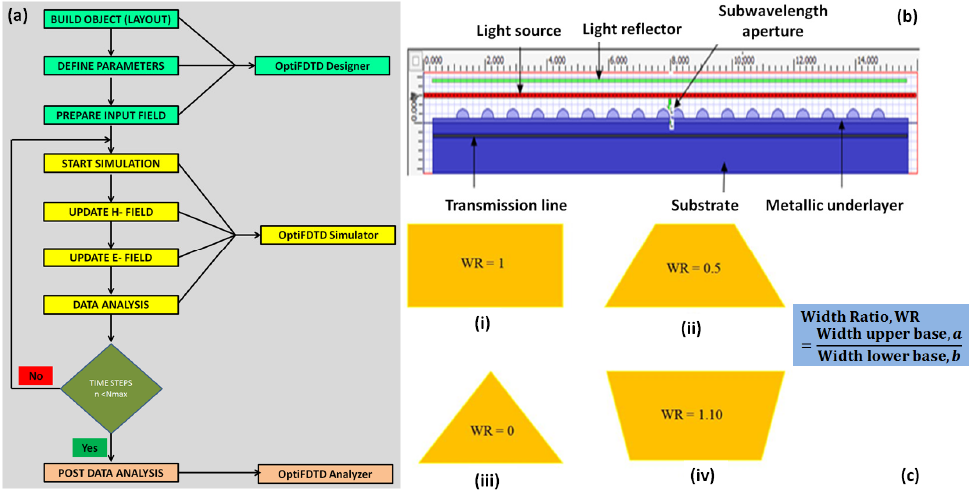
Figure 4. Schematic diagrams of the working flow of MSM-PDs modeling using FDTD simulating tools ( a ), nano-structure grating assisted modeling feature ( b ), and various designs of nano-structure grating with the definition of working ratio (WR) (i-Rectangular, ii-Trapezoidal, iii-Triangular, and iv invers Trapezoidal) (c) [76,77].